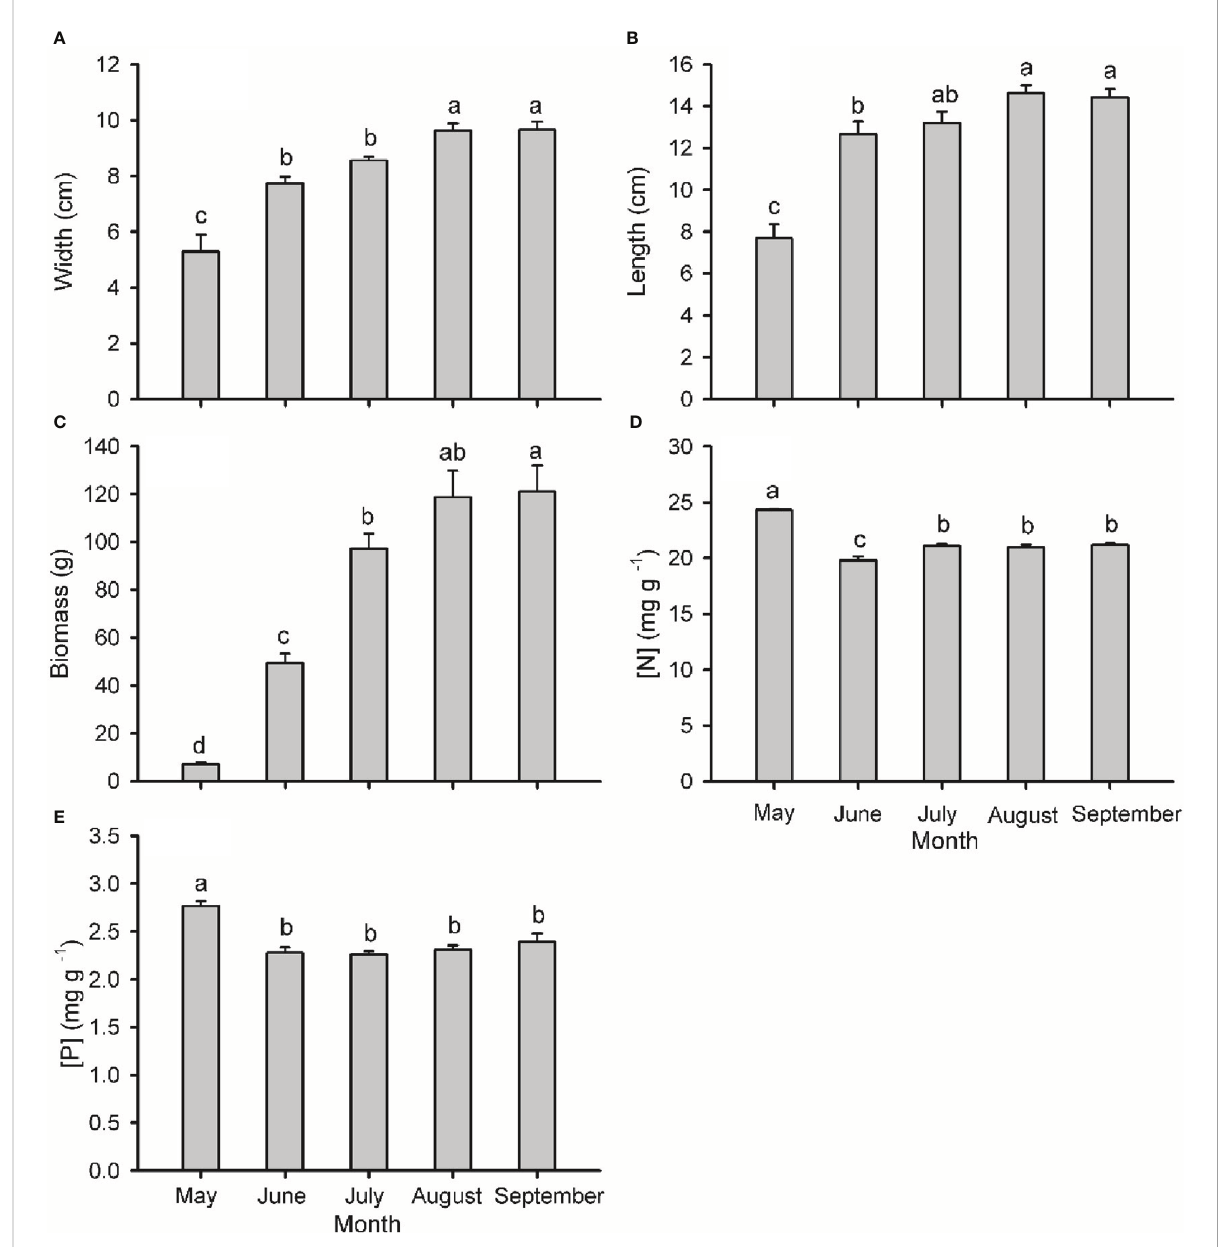
FIGURE 5 Width (A) , length (B) , individual biomass (C) , nitrogen concentration ( [N]; D) and phosphorus concentration ( [P]; E) in cones of Pinus koraiensis at fi ve sampling times (May, June, July, August and September, corresponding to DOYs 128, 172, 204, 237 and 258, respectively). Bars and arrows represent the mean and corresponding standard error from fi ve trees, respectively. Different lowercase letters indicate signi fi cant differences among sampling